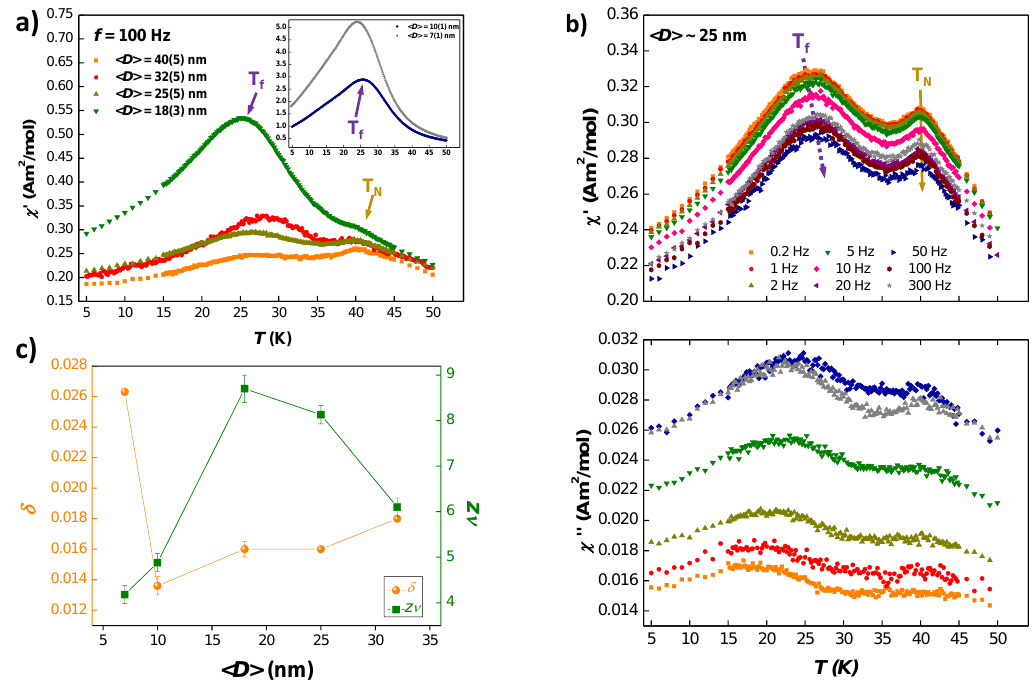
Figure 6. ( a ) Real χ (cid:48) ( T , f ) component of AC-susceptibility measured at f = 100 Hz for all of GdCu 2 -NPs. In the inset, NPs of (cid:104) D (cid:105) = 10(1) nm and (cid:104) D (cid:105) = 7(1) nm, where no trace of T N is found. ( b ) Real χ (cid:48) ( top ) and imaginary χ (cid:48)(cid:48) ( bottom ) components of AC-susceptibility measured for GdCu 2 1.5 h milled at several frequencies. Arrows indicate the position of T f and T N . ( c ) Evolution of δ and z ν with mean particle size (cid:104) D (cid:105) . A minimum (maximum) for δ -parameter (z ν ) is reached for (cid:104) D (cid:105) = 18 nm i.e., t = 1.75